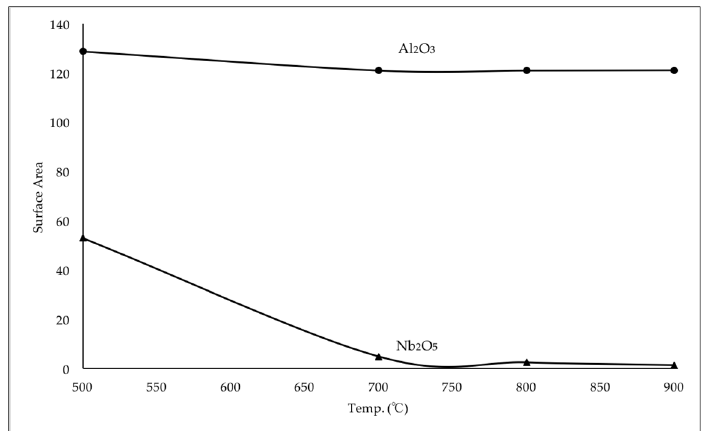
Figure 9. Surface area of Al 2 O 3 and Nb 2 O 5 pre-calcined at different temperatures. BET test was